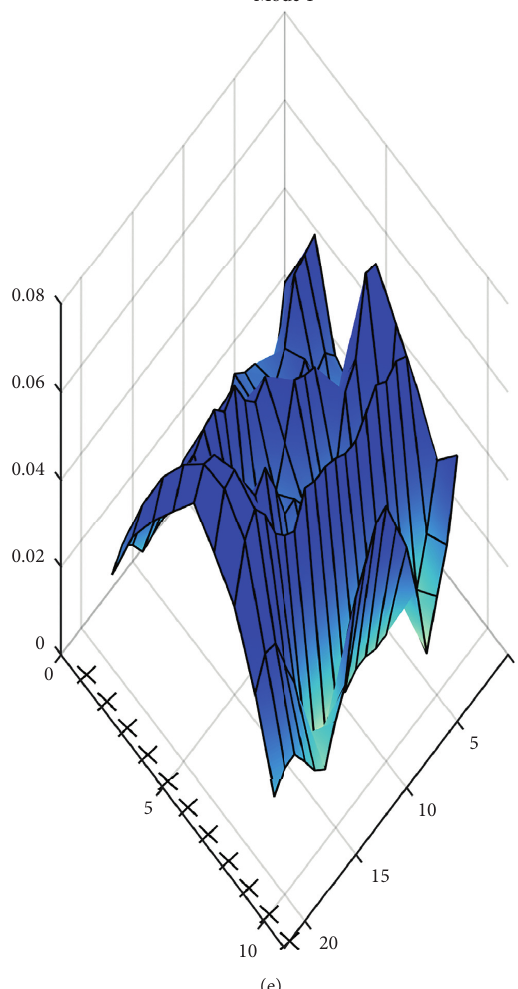
Figure 12: Comparison of mode shapes acquired for the first mode, for two intact states, (a) before (M#1) and (b) after reassembly (M#3), and for (c) damage one fully developed (M#11) along with differences for the respective mode shapes. (d) M#1–M#3 and (e)